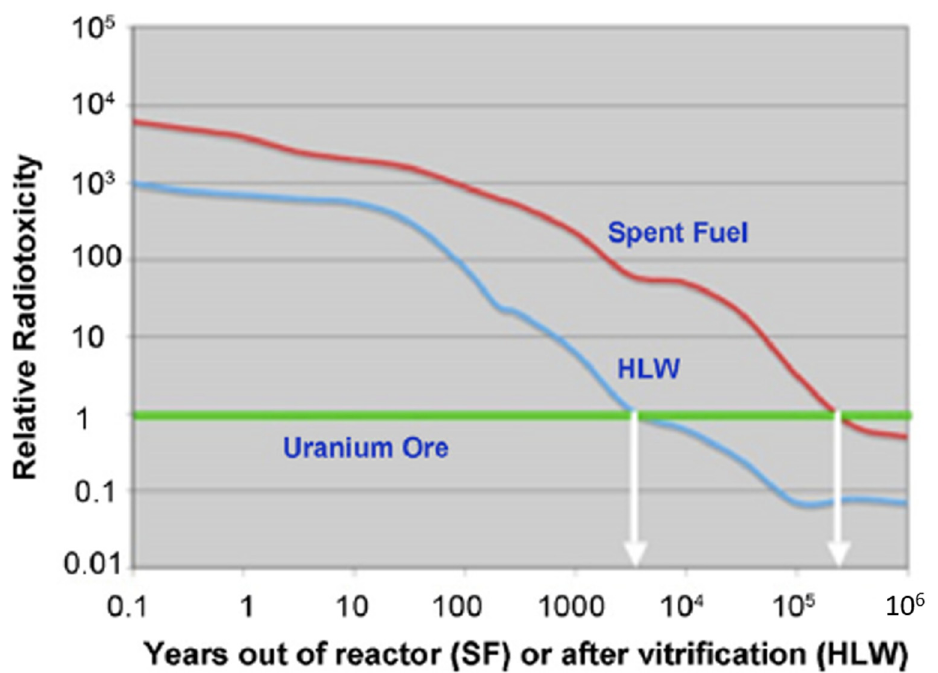
Figure 5. The relative toxicity index ( RTI ) of spent nuclear fuel (SNF) and high-level radioactive waste (HLW). Reproduced with permission of Elsevier from [22]. waste (HLW). Reproduced with permission of Elsevier from